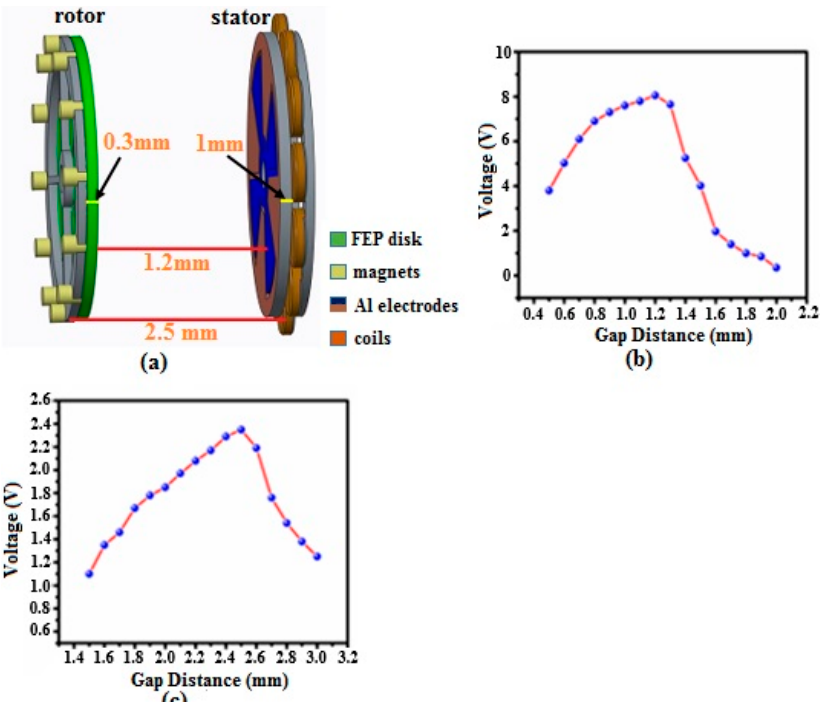
Figure 13. ( a ) The dimensions and the gap distance between the rotor and stator; ( b ) relationship between the gap distance and output voltage for the TENG; and ( c ) relationship between the gap distance and output voltage for the EMG.